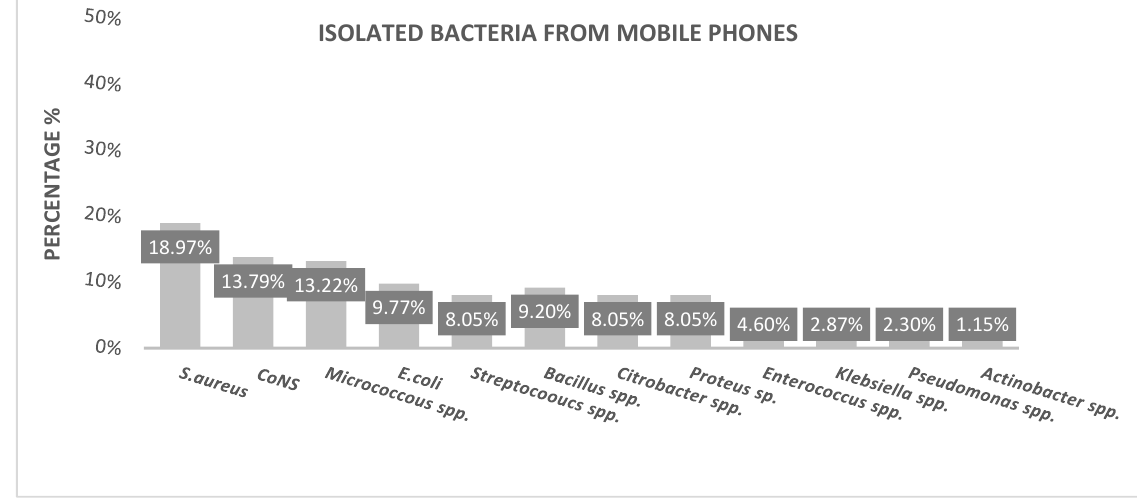
Figure 1. Mobile bacterial distribution profile. S. aureus; CoNS; Micrococcus species; E. coli; Streptococ-